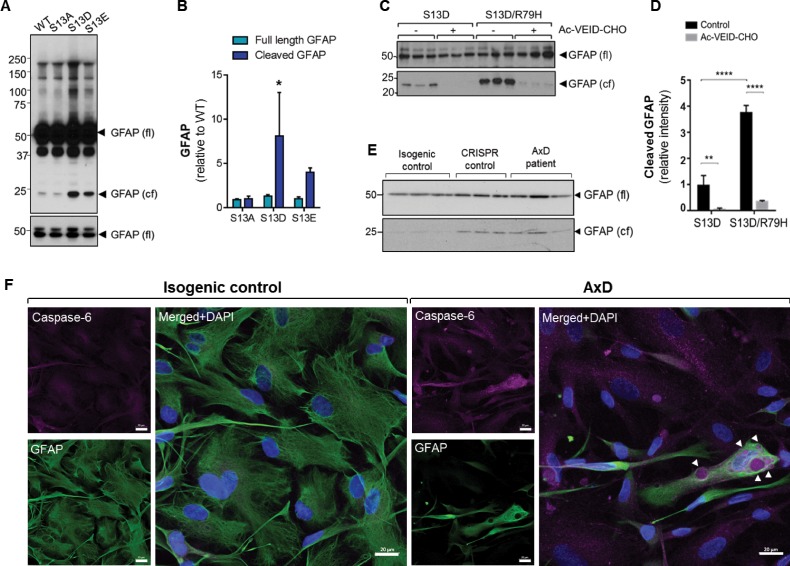
Phosphorylation of Ser13 on GFAP promotes caspase-6 cleavage of GFAP.(A) GFAP blot of SW13vim- cells transfected with vector, WT, S13A, S13D and S13E - GFAP. Full-length (fl) and cleaved fragment (cf) of GFAP are indicated by arrows. Immunoblot on the bottom shows GFAP monomer (fl) from the same membrane at a lower exposure. (B) Quantification of panel A by densitometry shows cleaved and full-length GFAP in phospho-mutants relative to WT GFAP (mean ± SD from three independent experiments; *p<0.05 two-way ANOVA). (C) GFAP blot in SW13vim- cells transfected with either S13D or S13D/R79H double mutant GFAP and treated for 48 hr with a caspase-6 inhibitor (Ac-VEID-CHO). (D) Quantification of GFAP bands in panel C by densitometry (mean ± SD from three biological replicates; **p<0.01; ****p<0.0001 two-way ANOVA). (E) Immunoblot for GFAP monomer (fl) and cleaved fragment (cf) in isogenic control and AxD iPSC-astrocytes. Different amounts of total protein were loaded to normalize GFAP monomer levels. (F) Immunofluorescence staining of caspase-6 (magenta), GFAP (green) and DAPI (blue) in human AxD and isogenic control iPSC-astrocytes showing caspase-6 co-localization within GFAP aggregates in the AxD cells, indicated by the arrowheads. Scale bars = 20 µm.Figure 7—source data 1.Raw data from mass spectrometry PTM profiling of GFAP R79H extracted from transfected SW13vim-cells.